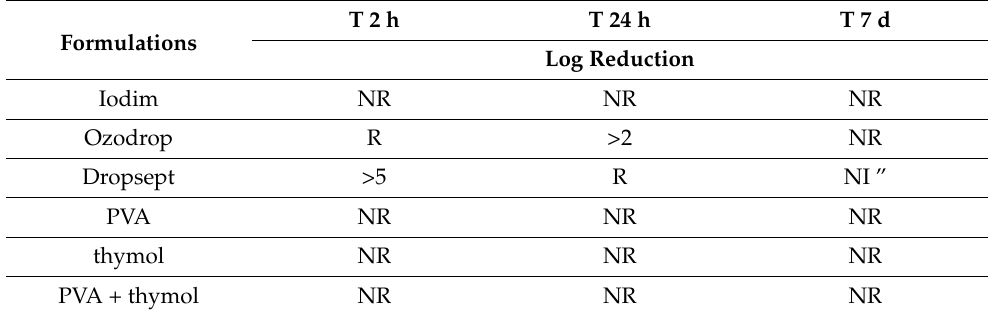
Table 9. Challenge test on P. aeruginosa .